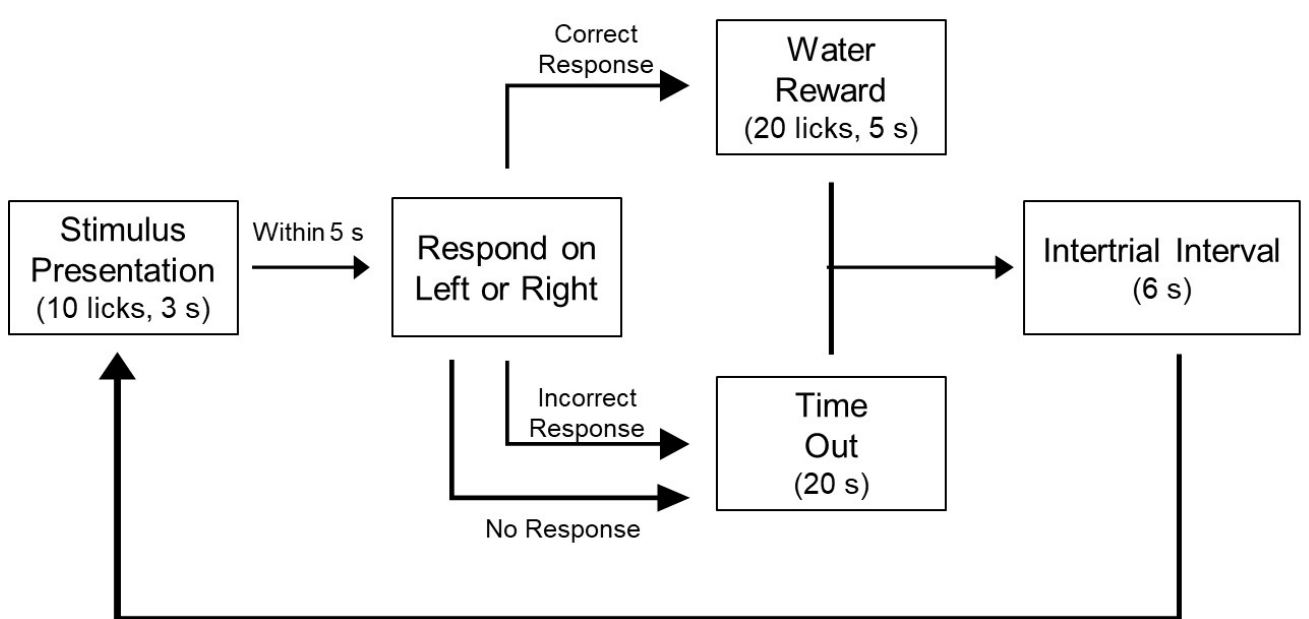
Figure 1. Flowchart of trial parameters. Once a trial had begun, animals had to sample the stimulus and very quickly decide on which side to respond. If they were correct, they received a water reward; if they were incorrect or did not respond, they received a timeout.